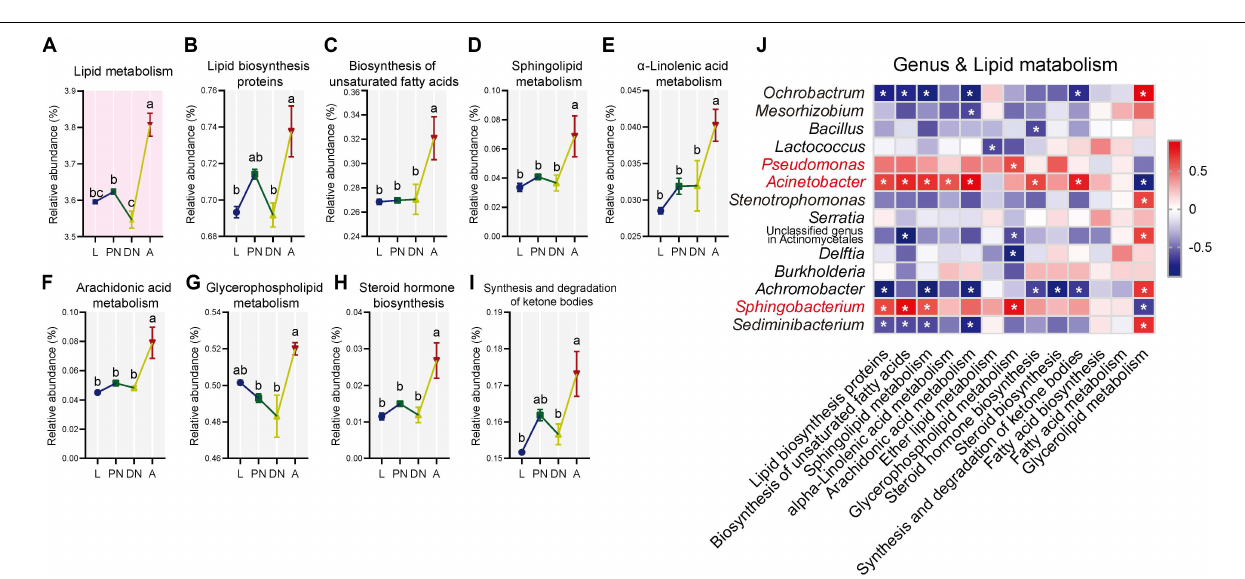
FIGURE 4 | Bacterial community dissimilarity across the lifespan of P. citri based on weighted UniFrac metrics. (A) Sample distance heatmap analysis at class level. (B) Analysis of unweighted pair-group method with arithmetic mean (UPGMA) based on hierarchical clustering at genus level. (C) Principal coordinated (PCoA) analysis at OTU level; the significance of variation in communities across four life stages was analyzed by analysis of similarities (ANOSIM) test with 999 permutations. L, PN, DN, and A indicated the larva, protonymph, deutonymph, and adult stages, respectively.